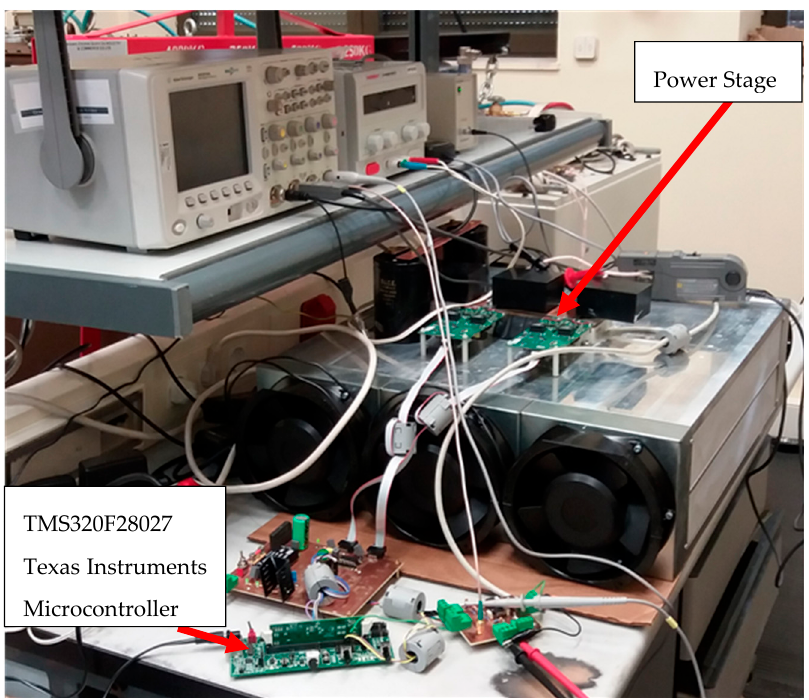
Figure 13. Converter Test Bench with digital control.